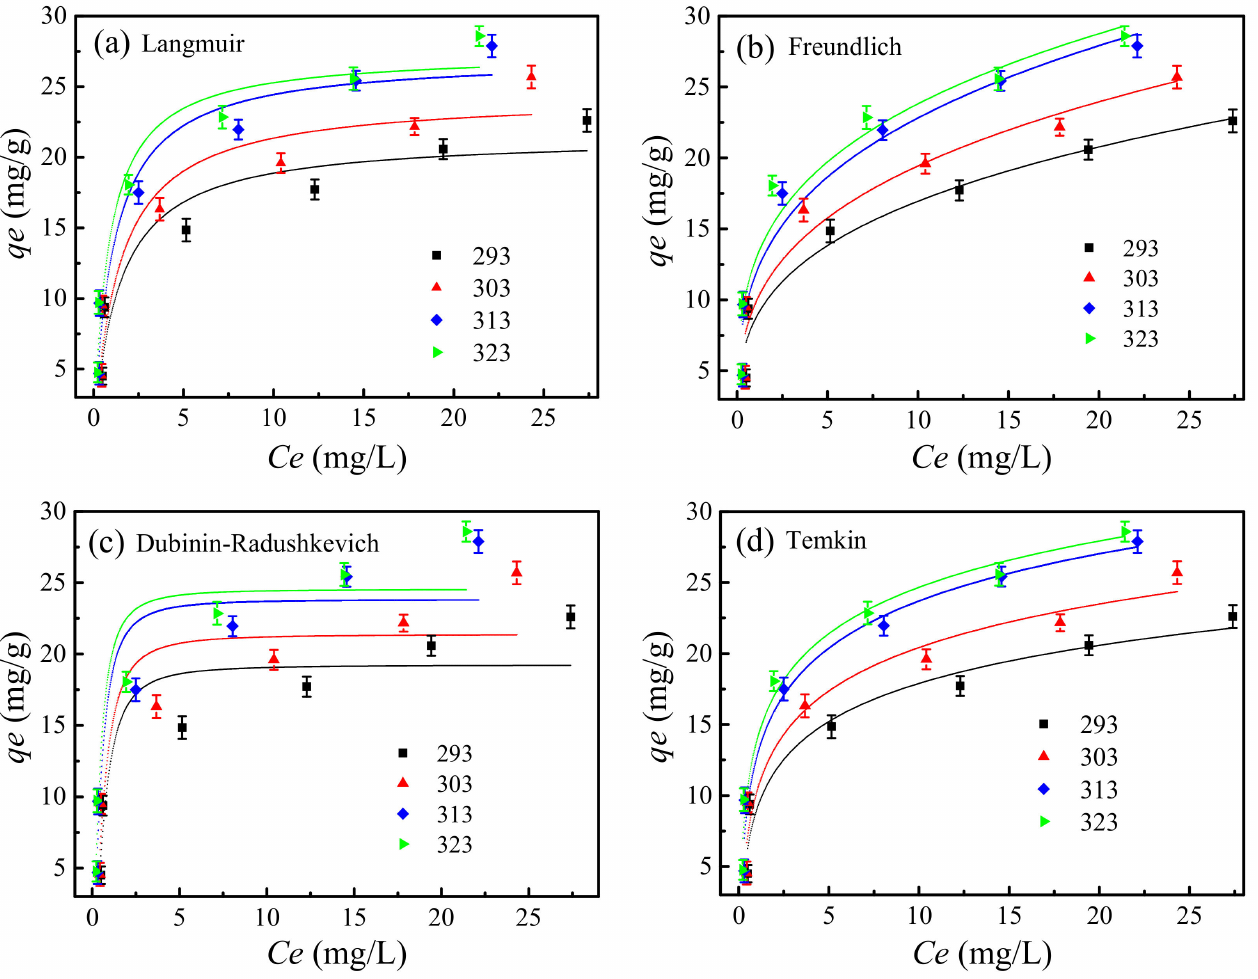
Figure 12. The fitting adsorption isotherm models for ( a ) Langmuir, ( b ) Freundlich, ( c ) Dubinin-Radushkevich, and ( d ) Temkin at different